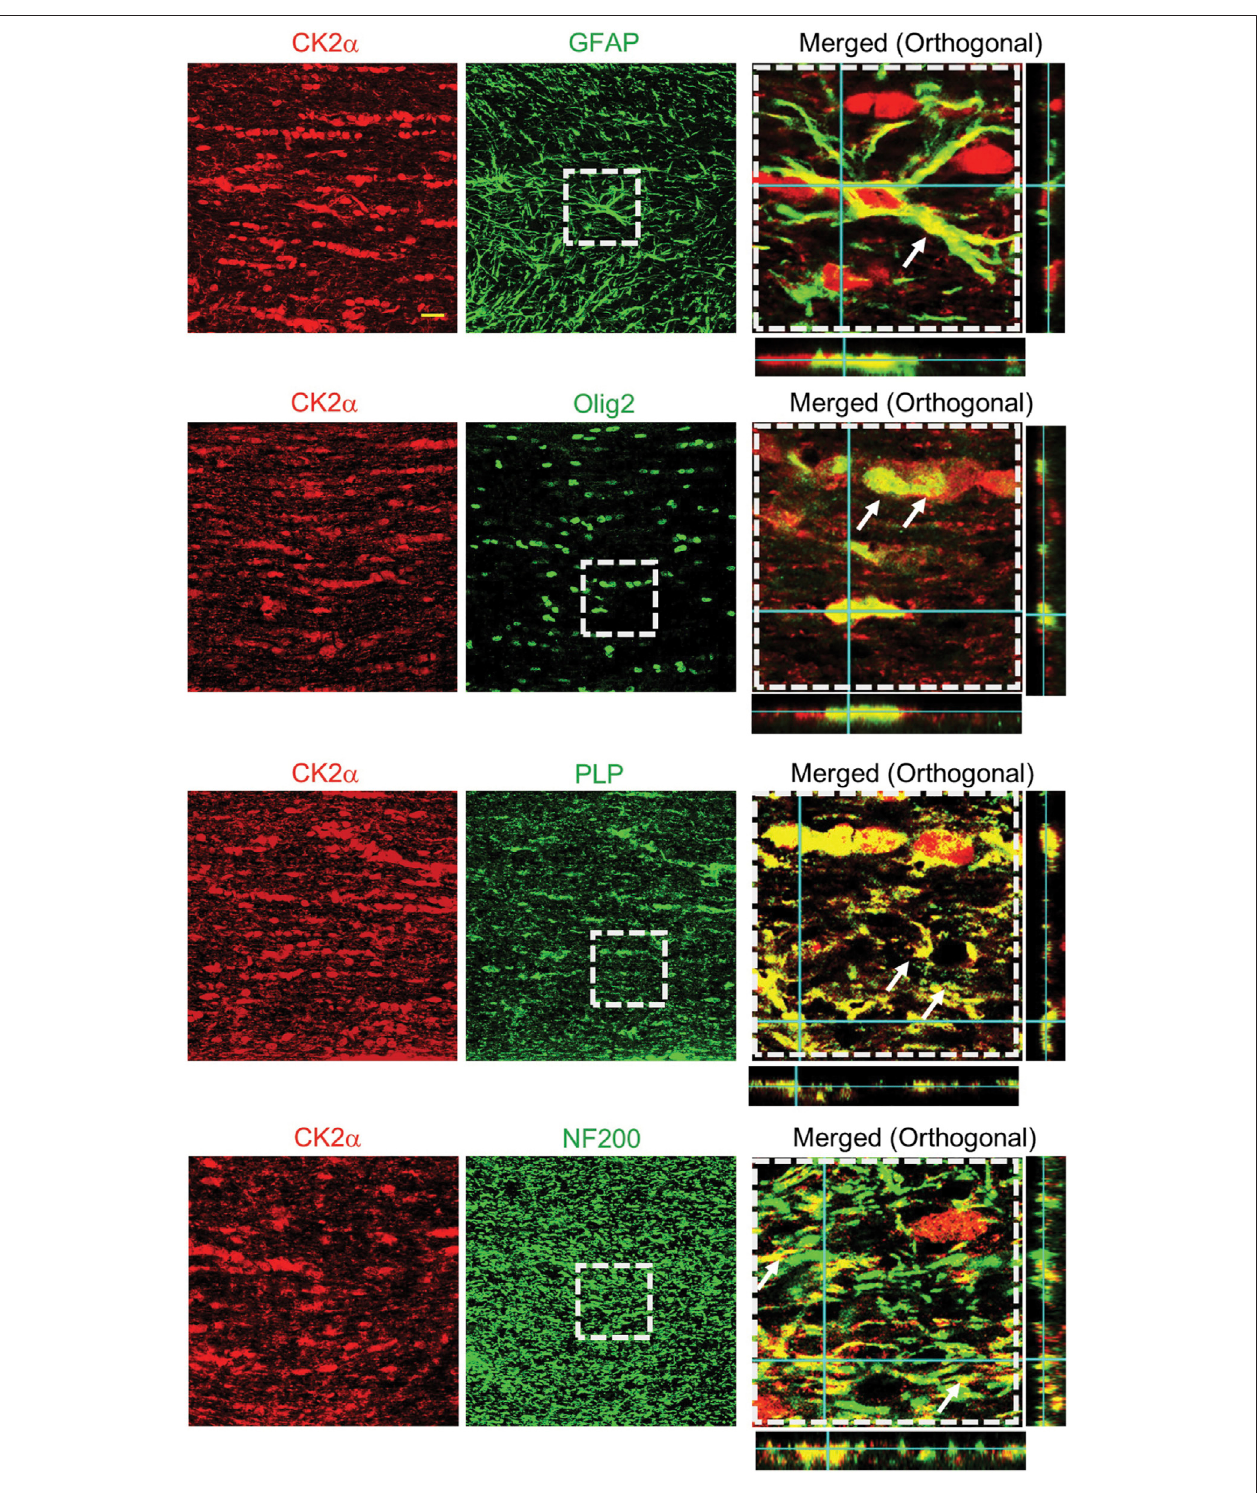
FIGURE1| CK2 α expressionandlocalizationinmouseopticnerves.CK2 α subunitsareexpressedinopticnerveastrocytes,myelinsheath,andoligodendrocytes. To identify the cellular expression of CK2 α subunits in the mouse optic nerve, CK2 α wasco-immunolabeled with glial fi brillary acidic protein (GFAP, astrocytes, top row), oligodendrocyte lineage transcription factor 2 (Olig2, oligodendrocytes, second row), myelin proteolipid protein (PLP, myelin, third row), and neuro fi lament protein (NF200, axons, bottom row). Note that the merged images (xy, xz and yz orthogonal view) in the right panels are enlarged areas (50 μ m × 50 μ m) indicated by the squares with dashed lines in the middle panels. Scale bar = 20 μ m. (Figure from Bastian et al., 2019).